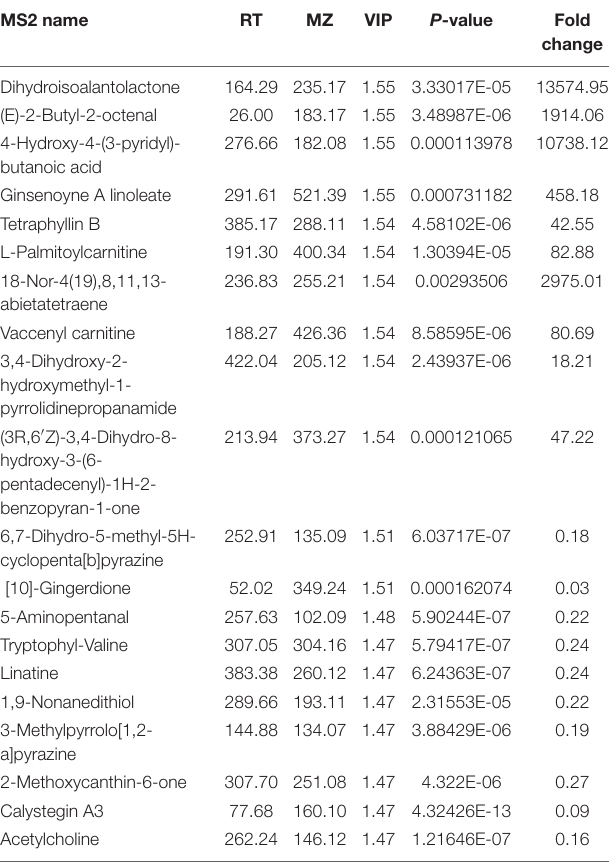
TABLE 1 | The top 20 most significantly changed metabolites in normal pregnant rats vs. GDM